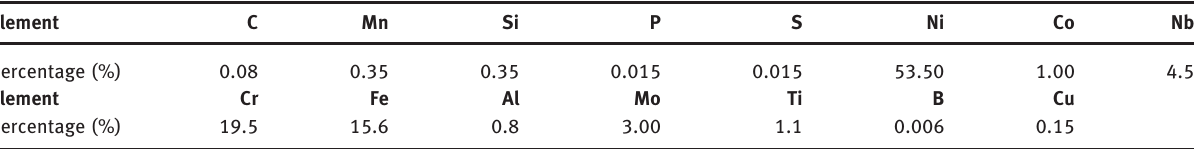
Table 1: Composition of Inconel